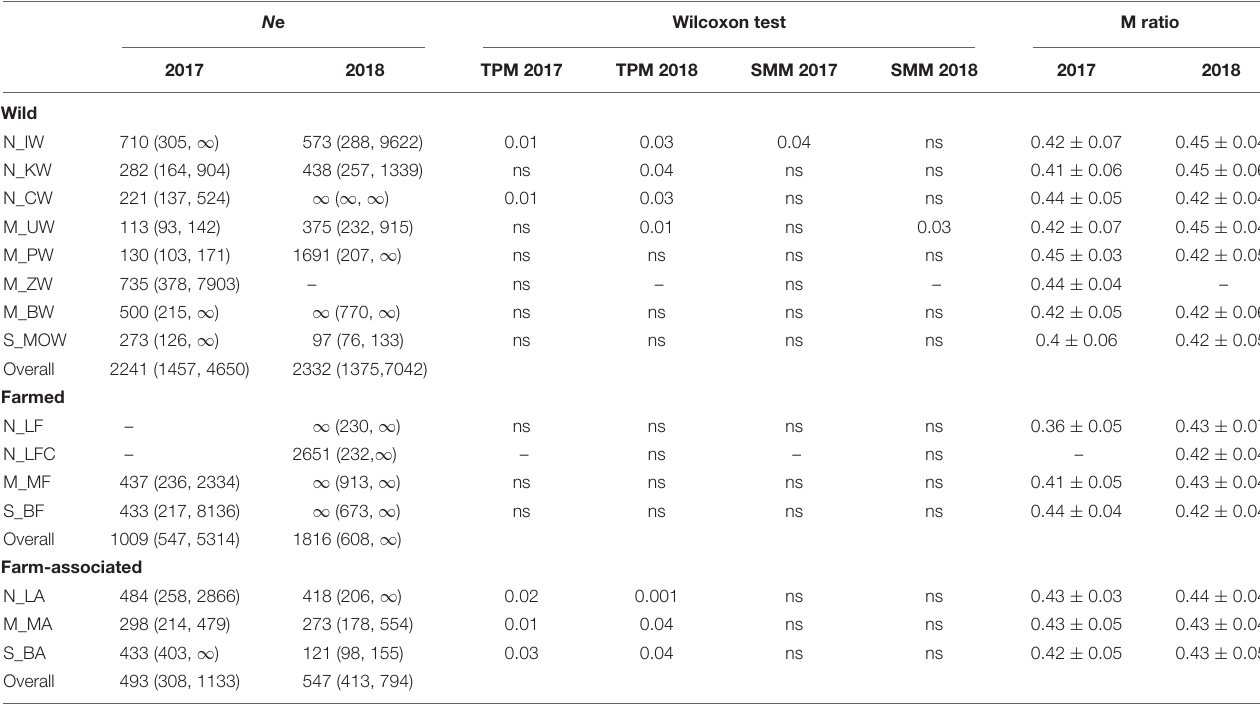
TABLE 3 | Effective population size ( N E ) of Ostrea edulis for 12 putatively neutral microsatellite loci and tests for genetic bottlenecks using two models of microsatellite allele mutations (TPM, two phase model and SMM, stepwise model) and the Garza-Williamson index (M ratio, Garza and Williamson, 2001). N e Wilcoxon test M